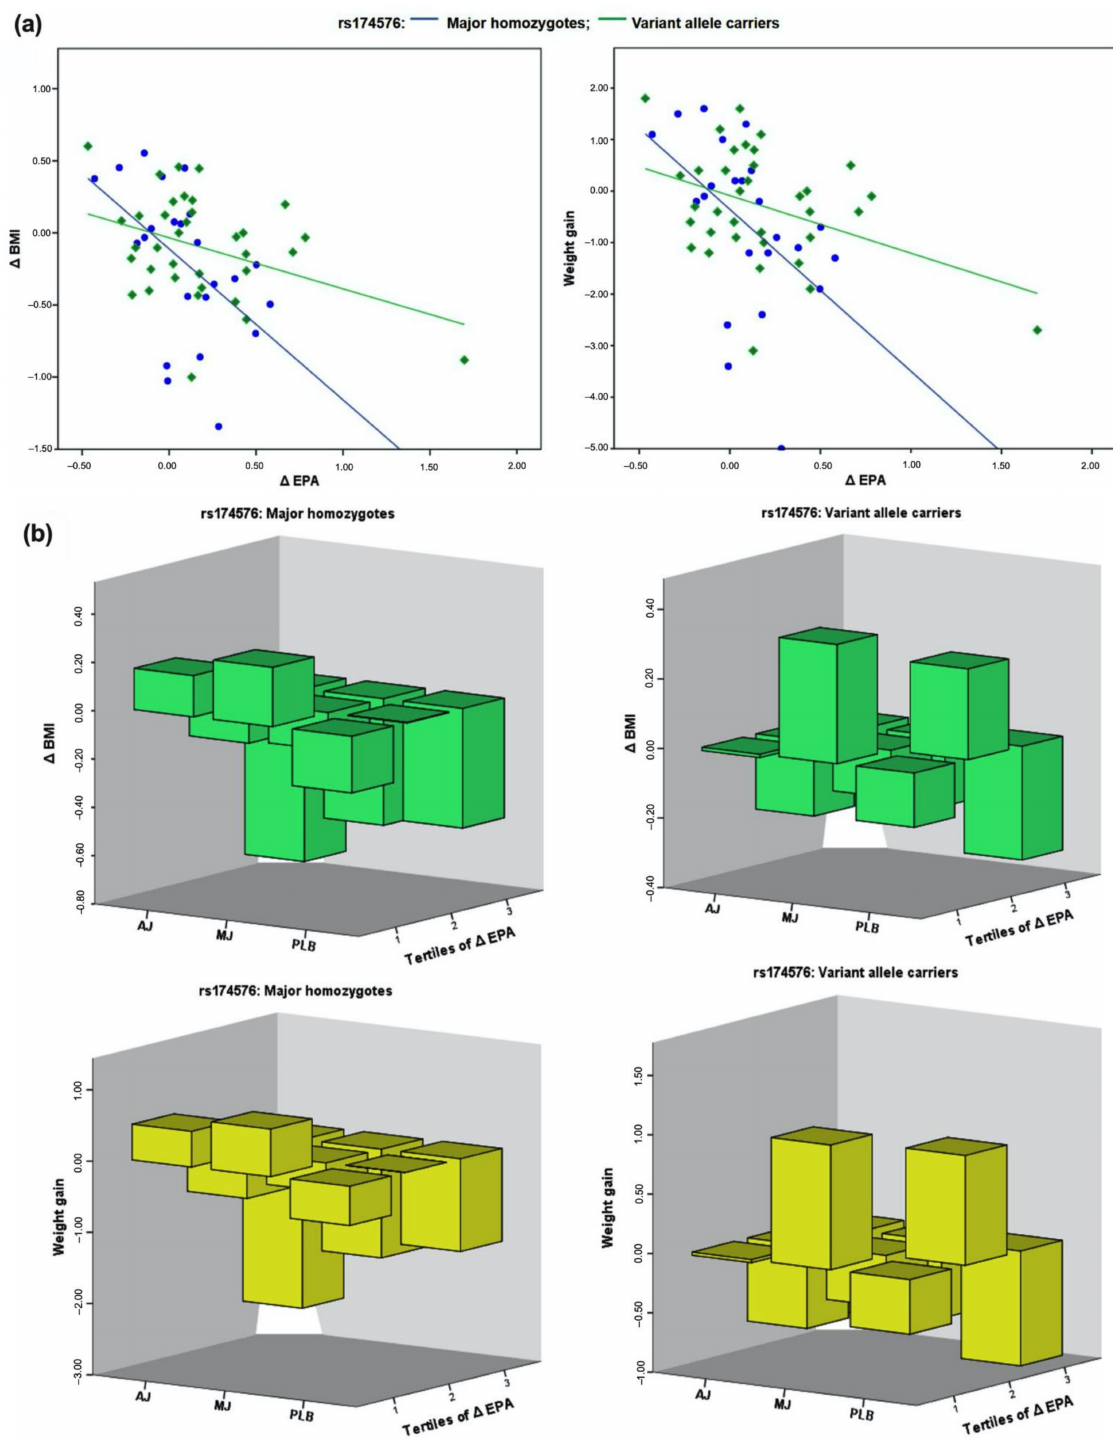
Figure 2. Dietary polyphenol- FADS2 (rs174576) interaction affecting the relationship between changes in EPA and BMI in overweight subjects (BMI ≥ 25) upon 4-weeks. ( a ) The associations between changes in EPA levels in plasma phospho- lipids with changes in BMI and weight gain, depending on the variant allele presence in FADS2 rs174576 variant place; ( b ) The associations between tertiles of changes in levels of EPA in plasma phospholipids with changes in BMI and weight gain, depending on the interventional treatments with varying polyphenol content (AJ, MJ, PLB) and presence of the variant allele in FADS2 rs174576 variant place. AJ, subjects drinking Aronia juice with 1177.11 mg of polyphenols (gallic acid equivalents, GAE) per 100 mL; MJ, subjects drinking Aronia juice with 294.28 mg of polyphenols (GAE) per 100 mL; PLB, subjects drinking a polyphenol-lacking placebo